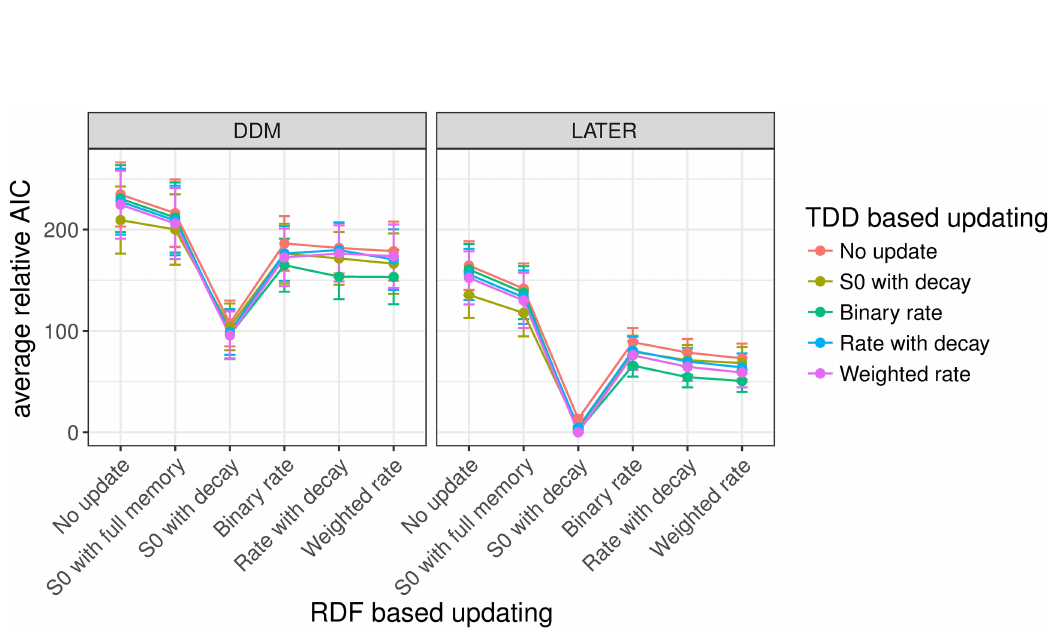
Fig 10. Mean relative AICs as a function of the tested models in Experiment 3. For each participant, the AIC of the best- performing model has been subtracted from the AIC for every model, before averaging across participants. Error bars indicate the standard error of the mean. The response-based updating rules are mapped onto the x-axis (RDF-based updating), while the dimension-based updating rules are indicated by different colors (TDD-based updating). The left-hand panel presents the results for the DDM, the right-hand panel for the LATER model. Only models with a non-decision time component are included in the figure. Models without a non-decision time component generally performed worse, and the best-fitting model included a non- decision time component (see also Table A in S4 Text).